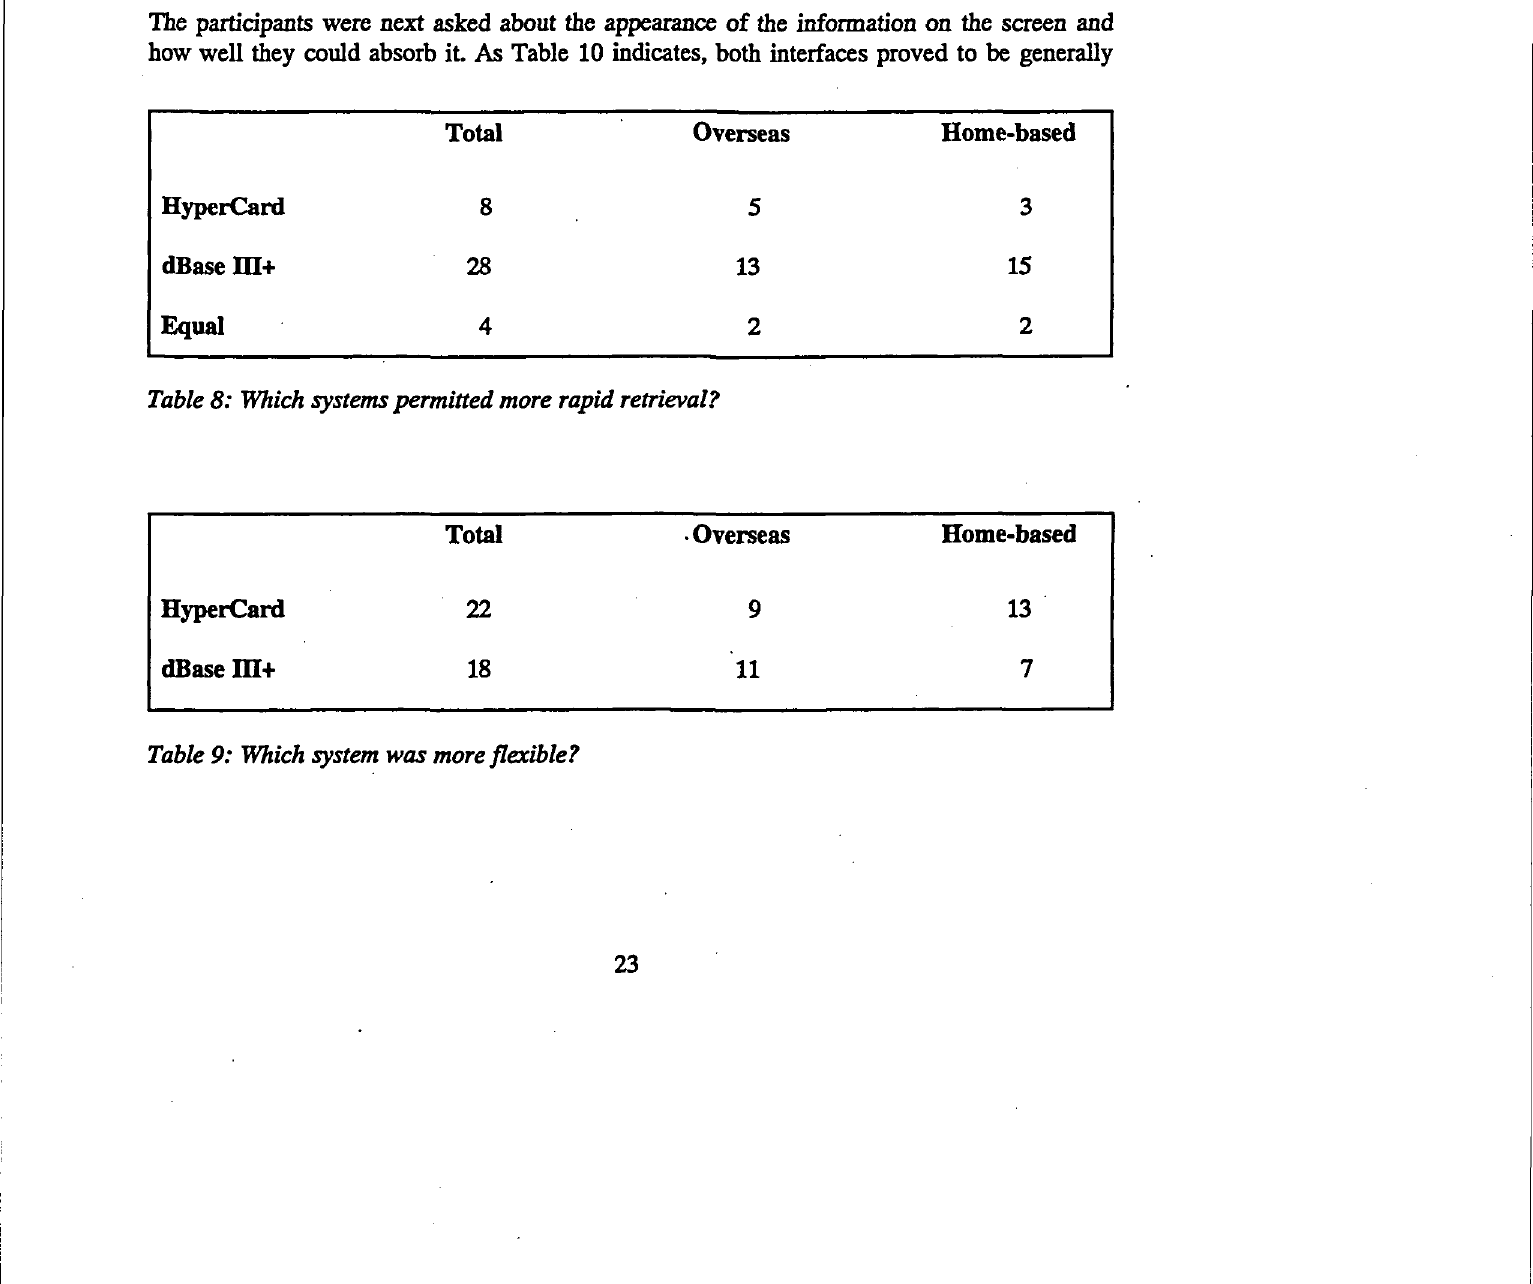
Table 8: Which systems permitted more rapid retrieval?